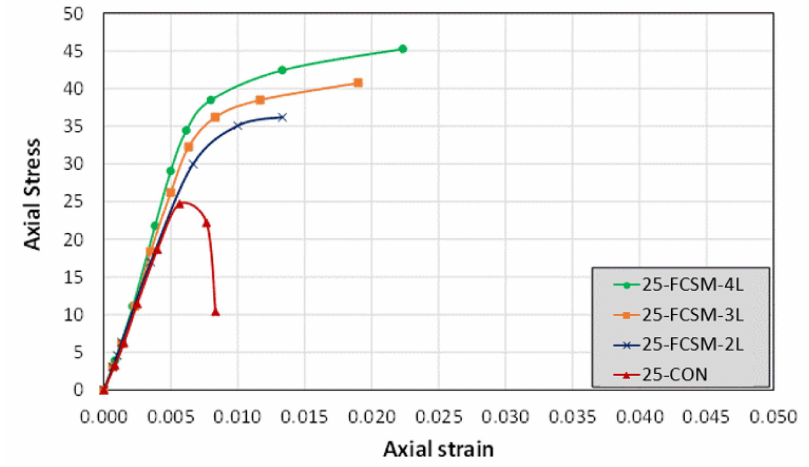
Figure 9. Compressive stress-strain curves of group 3 specimens.